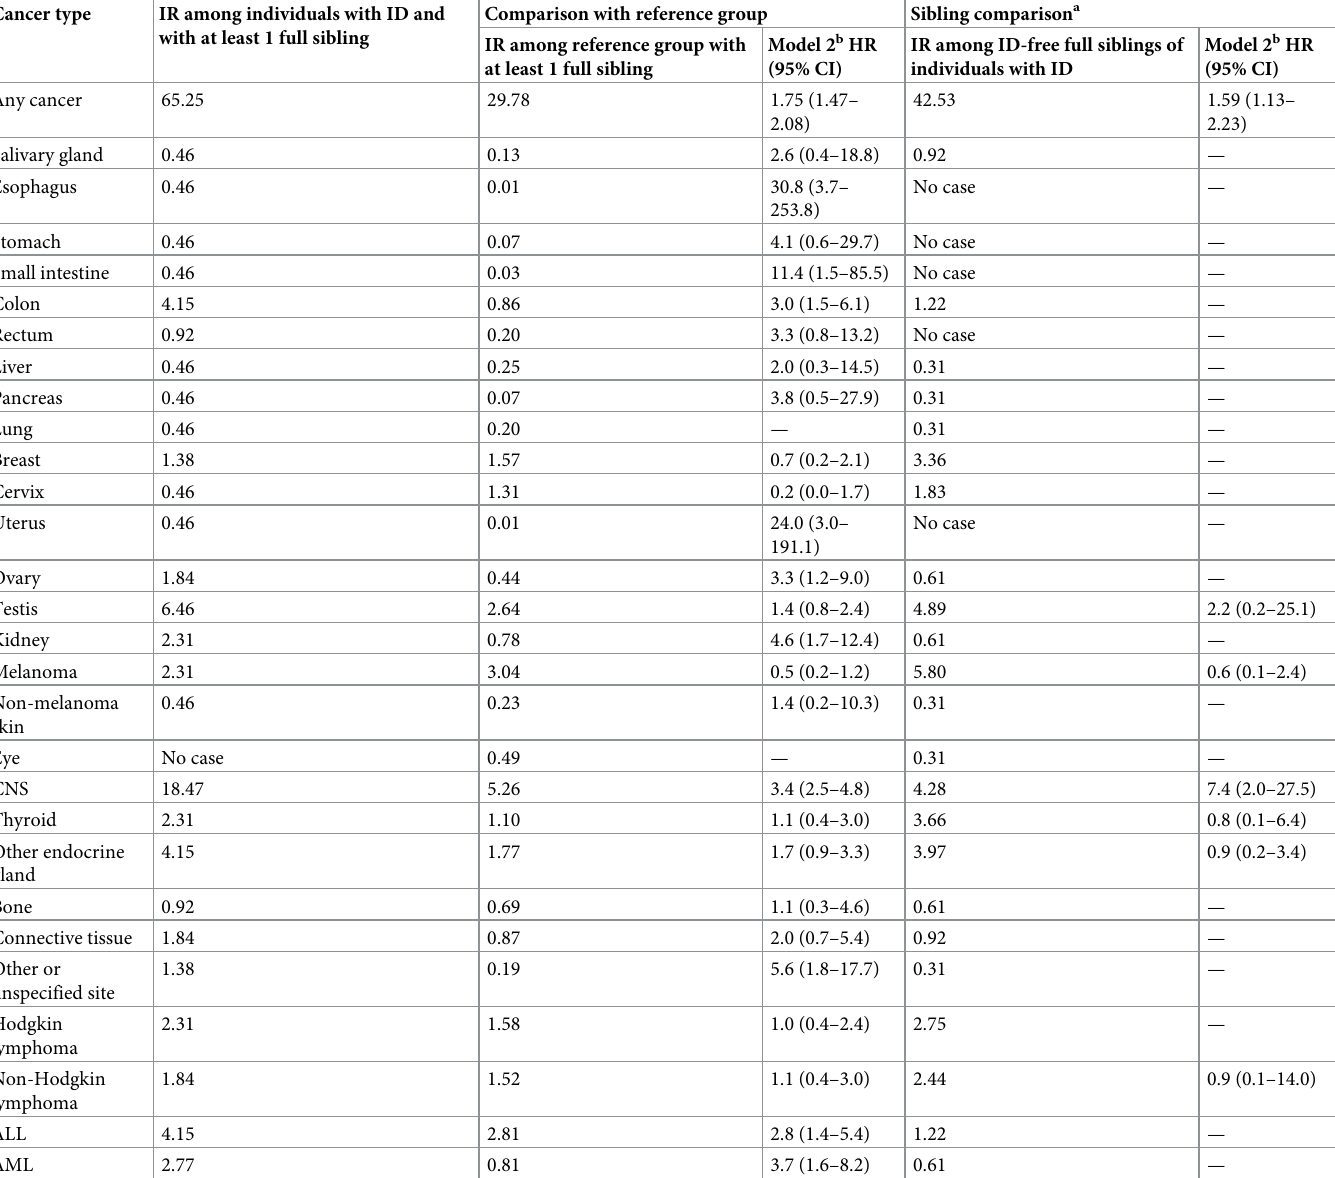
Table 3. Familial confounding: IRs (per 100,000 person-years) and HRs of cancer among individuals with ID, compared with their full siblings and the reference group—analyses restricted to individuals with at least 1 full sibling. Cancer type IR among individuals with ID and with at least 1 full